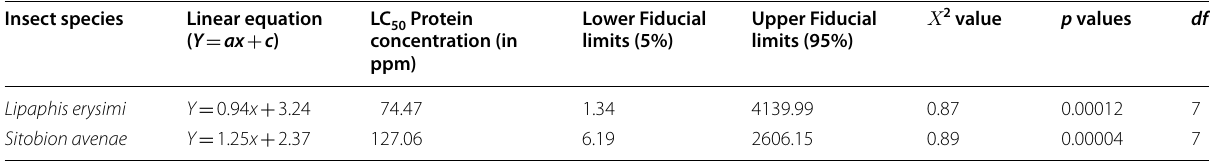
Table 4 Laboratory bioassay with crude protein extracts of Alternaria alternata VLH1 against major aphid pests of Rabi crops Insect species